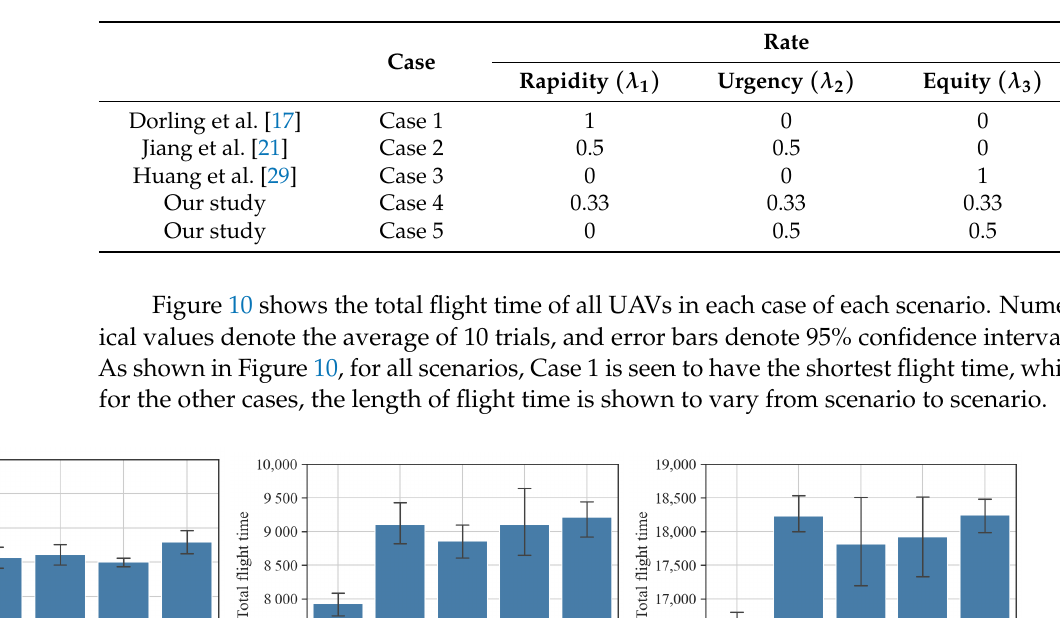
Table 6. Rate of reward for each case.